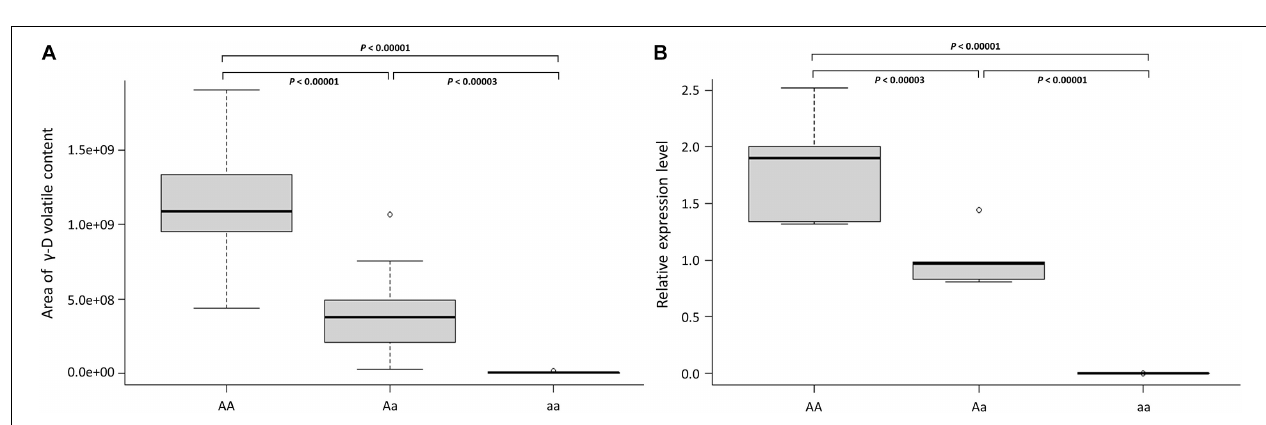
FIGURE 6 | FaFAD1 transcript dosage regulates γ -D content in the octoploid strawberry. (A) Distribution of γ -D volatile abundance per FaFAD1 genotype. Boxplot showing the area of γ -D volatile content of each genotype for 48 accessions shown in Table 2 . (B) Relative level of FaFAD1 transcript by FaFAD1 genotype. The boxplot represents gene expression distribution of each genotype, “AA” (FL 18.50-91, FL 18.50-52, FL 18.50-36, FL 18.50-124, and FL 18.50-96), “Aa” (FL 18.50-120, FL 18.50-49, FL 18.50-20, FL 18.50-42, and FL 18.50-65), and “aa” (‘Camarosa’, ‘Strawberry Festival’, ‘Mara des Bois’, ‘Treasure’, and ‘Winter Dawn’). AA: homozygote γ -D producer, Aa: heterozygote γ -D producer, aa: homozygote γ -D non-producer. The statistical significance of the differences was estimated using t -test. Boxplot: the black line in the middle of the boxes is the median, and the bottom and top of the boxes indicate the 25th and 75th percentiles. Whiskers (T-bars) are the minimum and maximum values. The empty dot is outlier. Both experiments (A,B) were done with three biological replicates and each replicate has at least three